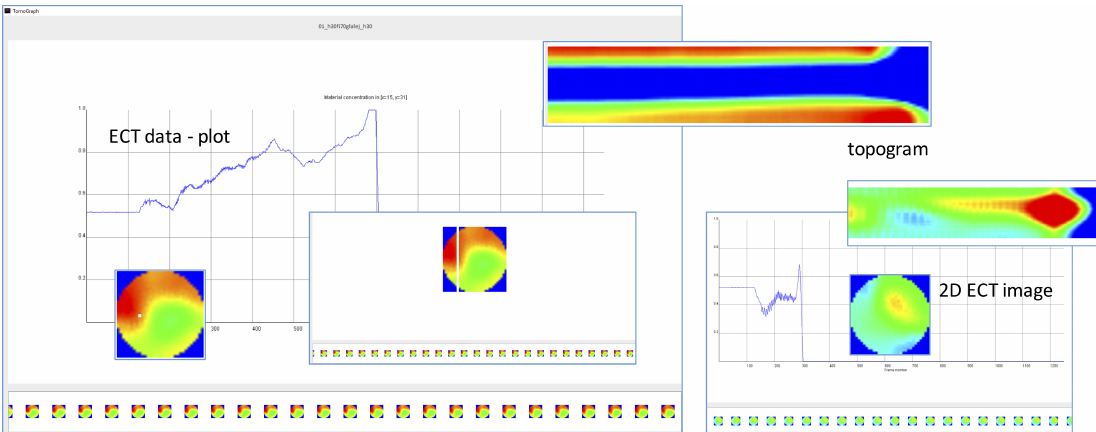
Figure 7. Screenshots of the INFORVIS system features. Demonstration of various interface elements and visual illustration implemented data workflow support features. From left: plot vs. time diagram, 2D cross-sectional single frame image, single pixel line time slice in the form of topogram. Bottom images illustrate consecutive time frames in the form of reconstructed 2D cross-sectional distribution